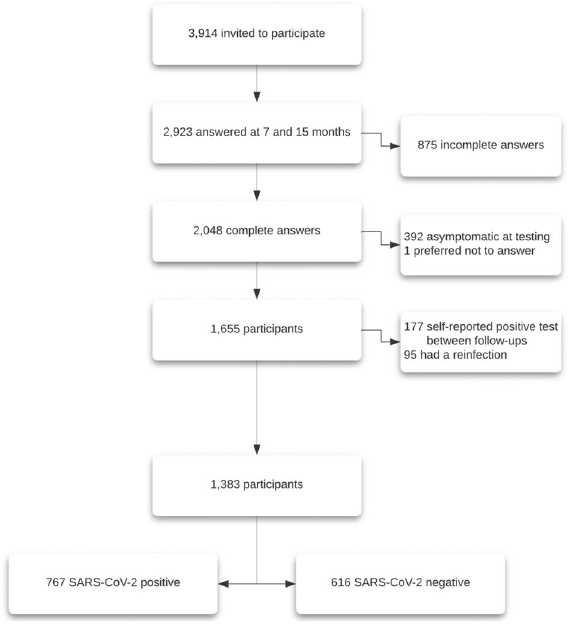
Figure 1. Flowchart with 1383 participants included out of 2923 who had a follow-up at 7 and 15 months. Out of the 1383 participants, 767 were SARS-CoV-2 positive and 616 were SARS-CoV-2